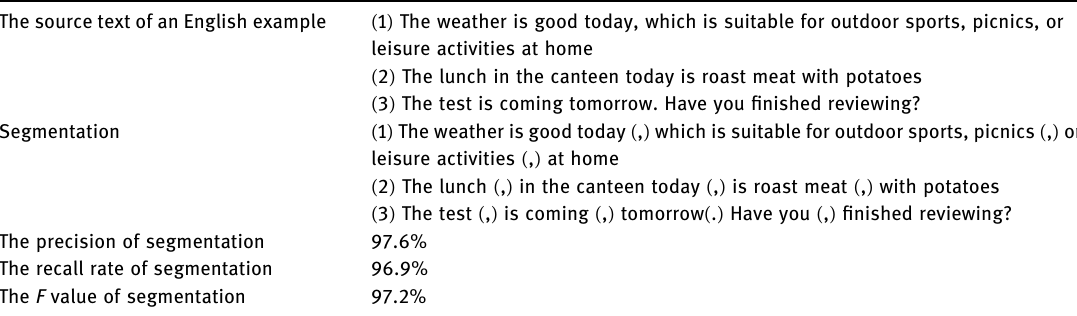
Table 2: Partial results of segmenting long English sentences with the improved intelligent machine translation algorithm and the overall segmentation performance The source text of an English